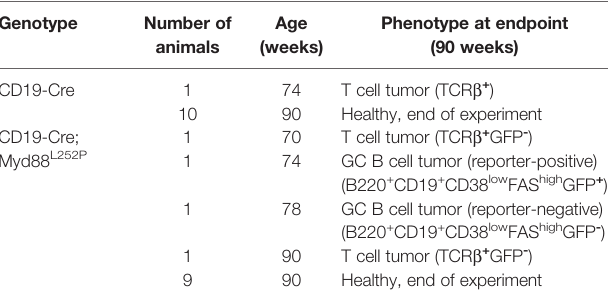
TABLE 1 | Myd88 L252P does not promote B